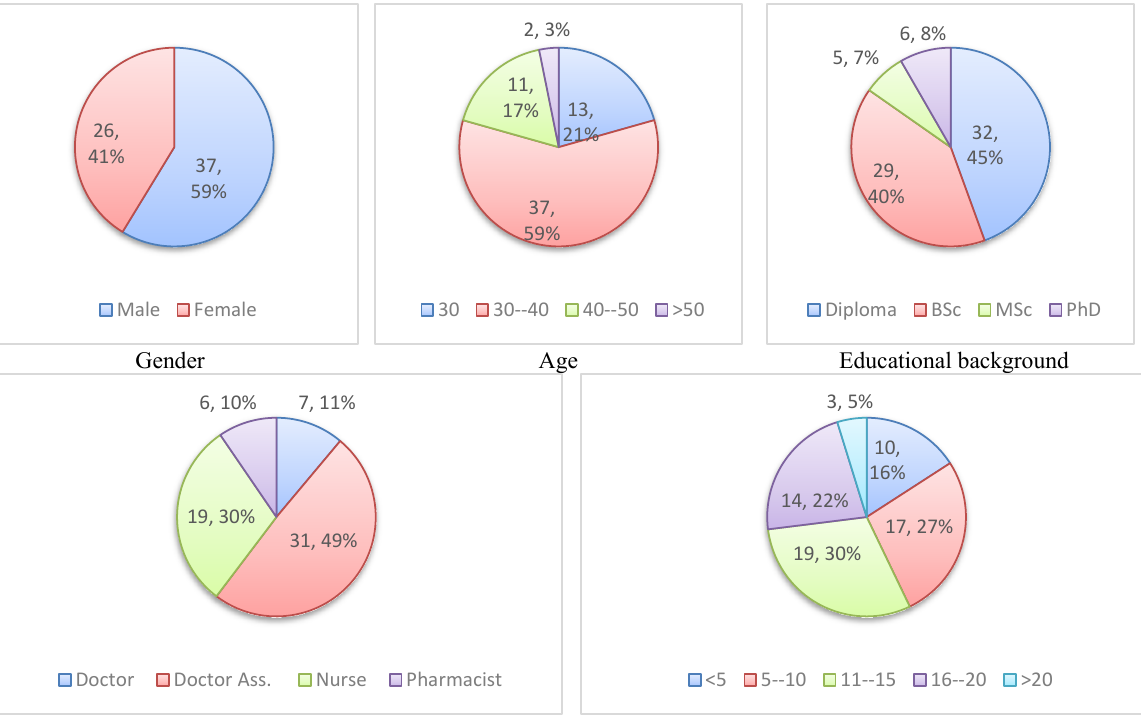
Fig. 2. Personal characteristics of the